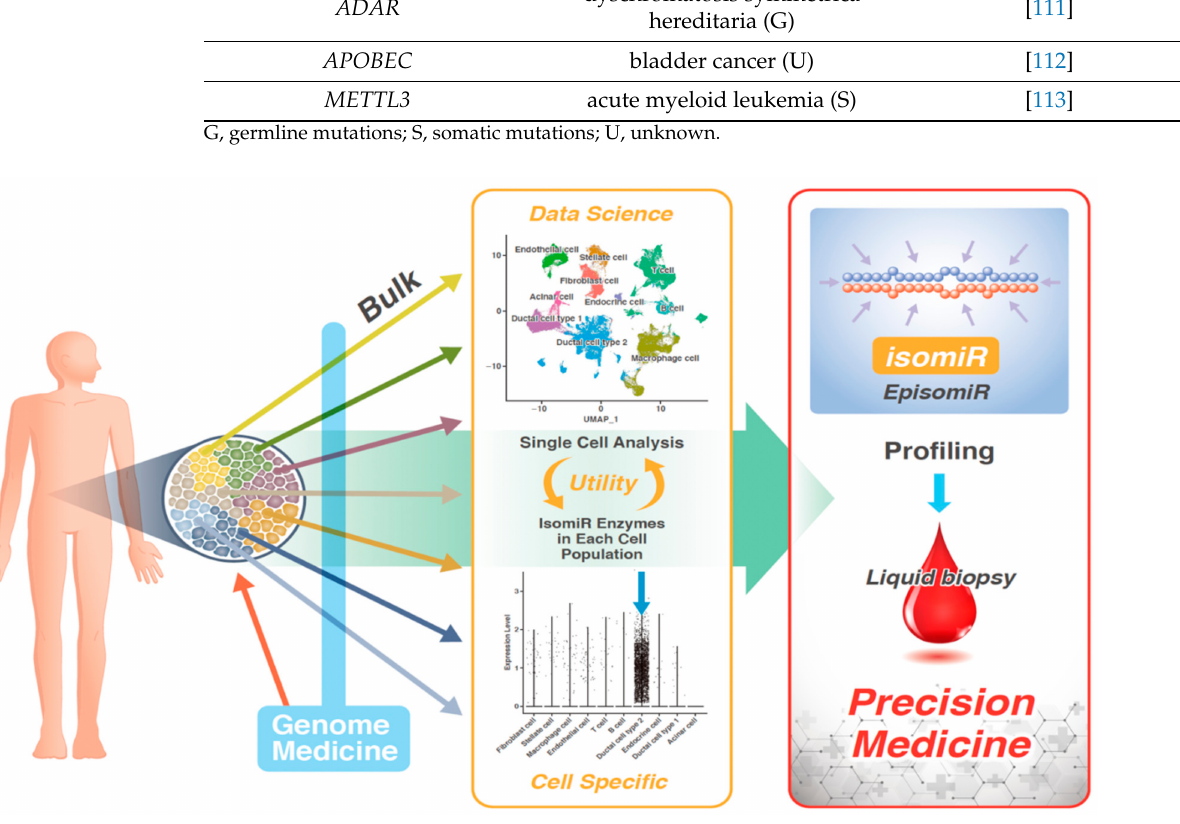
Figure 4. Outlook on high-precision medical care, achieved by the profiling of isomiR. A recent study, using single-cell sequencing of various tissues, has provided links with data from liquid biopsy, such as that of peripheral blood. Given that the expression of isomiR-generating enzymes varies, according to the cell populations present in tissues, the study of isomiR will enable the detection of cell-specific expression patterns. This will improve the diagnosis of diseases, in which unique expression patterns are observed due to genomic and epigenomic variabilities, and will enable the development of precision medicine based on liquid biopsy